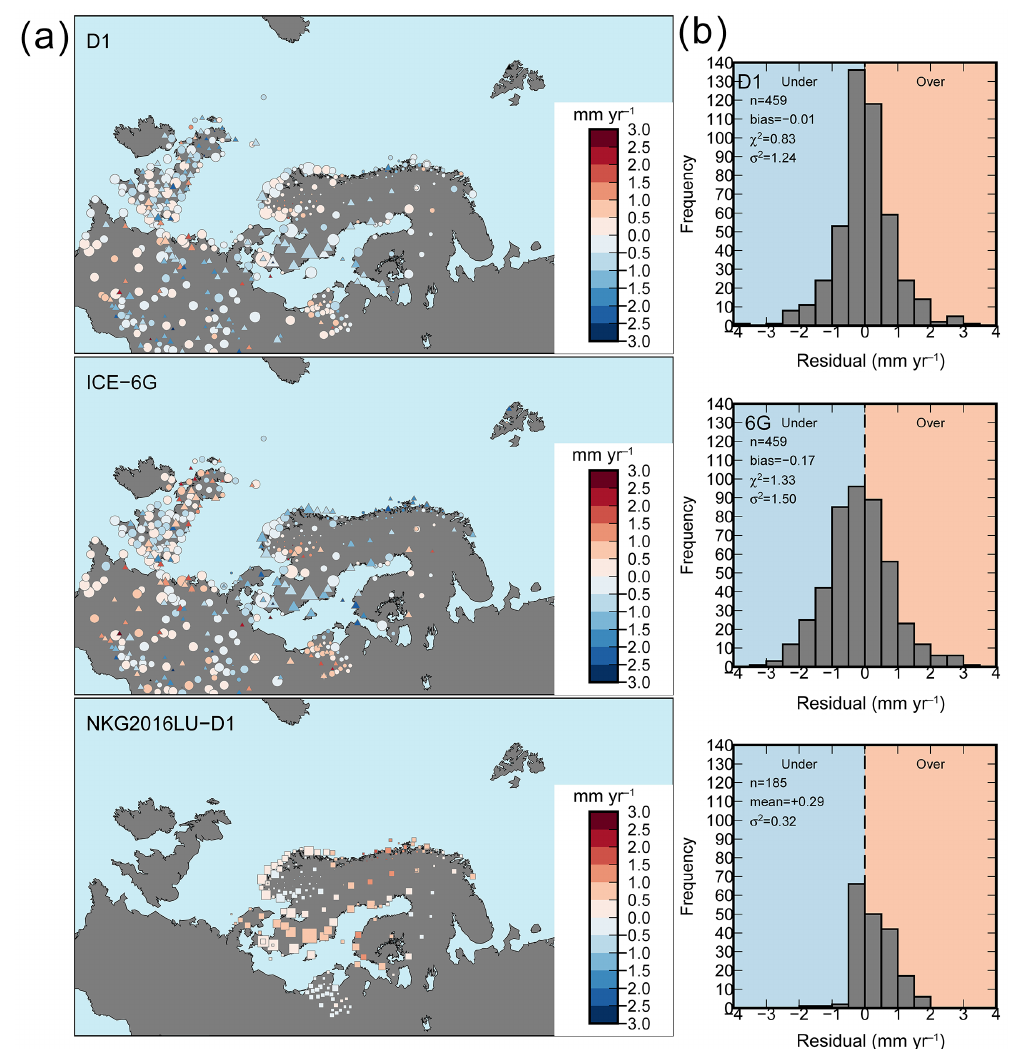
Figure 10. Spatial (a) and binned (b) vertical motion residuals for D1 and ICE-6G and the difference between the NKG2016LU and D1 models. Triangles indicate that model prediction is outside the 1 σ uncertainty of the measurement; circles indicate that model prediction is inside the 1 σ uncertainty of the measurement; squares show the difference between the two models (bottom panel in column a